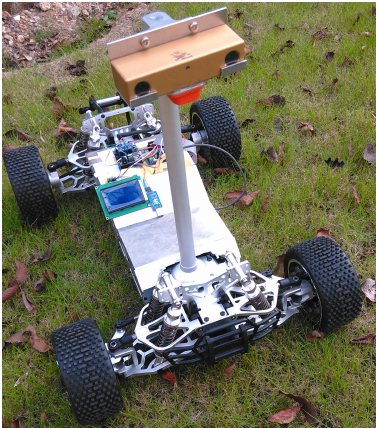
Figure 10. Mobile robot platform used in our experiments, the images are captured by the bumblebee stereo camera